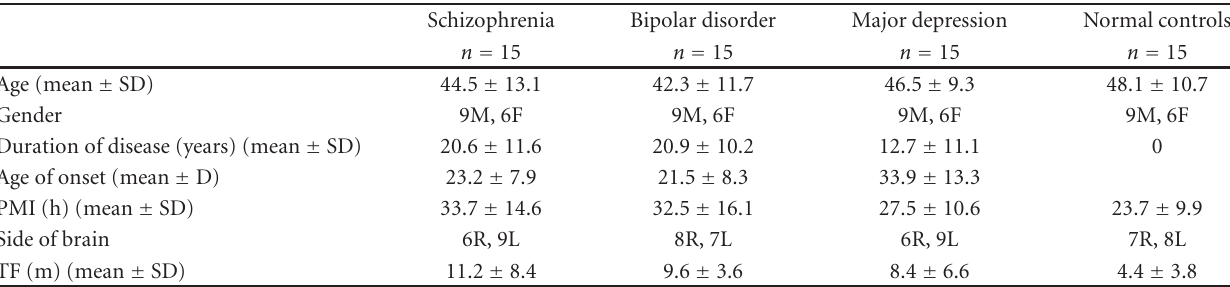
Table 1: Demographic data of SFNC brain collection.